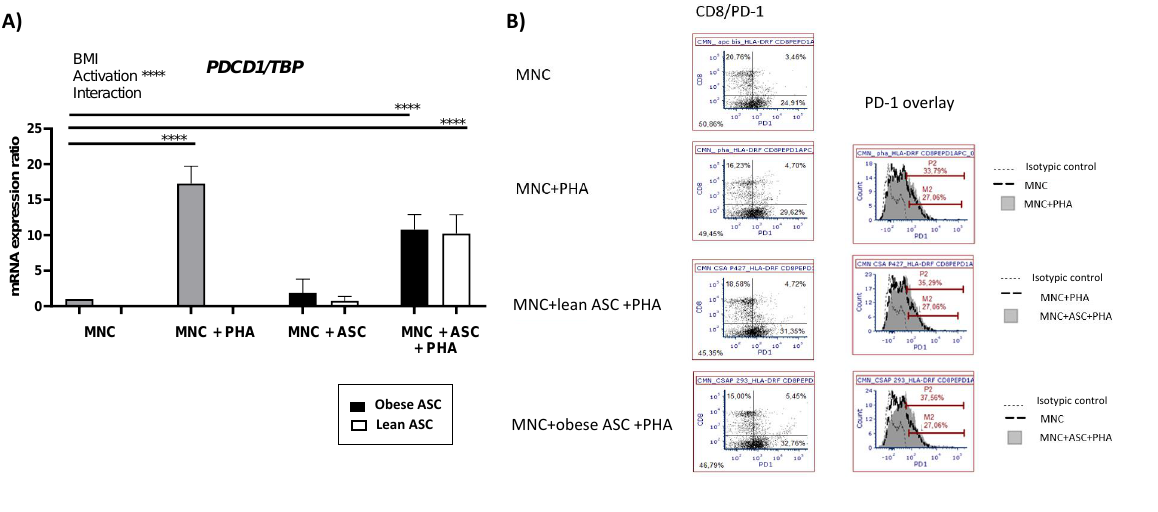
Figure 3. Activation of T cells upregulates PD-1 expression but is not influenced by ASC. MNC were activated by PHA in the presence or absence of ob-ASC or lean ASC. ( A ) PDCD1 (PD1) mRNA expression levels were measured by RT-qPCR. Results were expressed as a ratio relative to the TBP housekeeping gene. Two-way ANOVA with Fisher’s LSD comparison tests were used. Data are the mean ± SD of n = 4. **** represents a p -value <0.0001. ( B ) Membrane expression of PD-1 was measured by flow cytometry in cells also stained for CD8. Results are representative of two experiments with two different